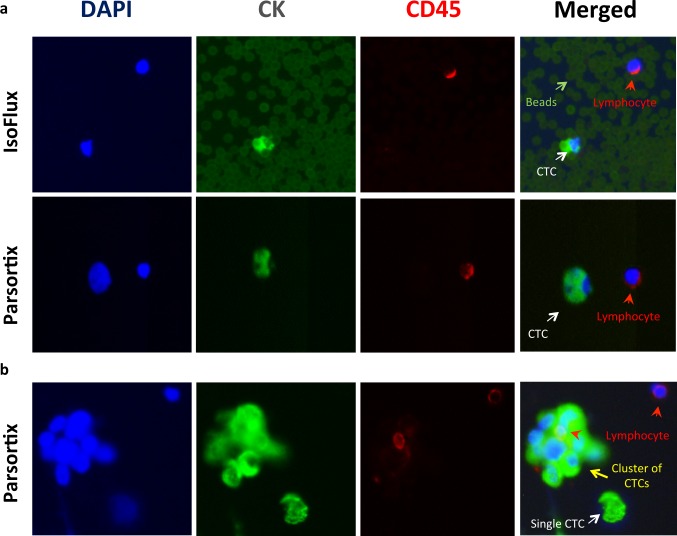
Representative images for the identified CTCs in parallel study.(A) Images of single CTCs. The upper row: cells harvested by IsoFlux with beads around cells. The lower row: cells harvested by Parsortix without beads around. (B) A cluster of CTCs (yellow arrow), single CTC (white arrow) and surrounding lymphocytes (arrowhead) were observed in samples harvested by Parsortix. Signals for nucleus, cytokeratin and CD45 were presented separately and then merged together. A CTC is defined as a CK positive/CD45 negative, nucleated and morphologically intact cell.